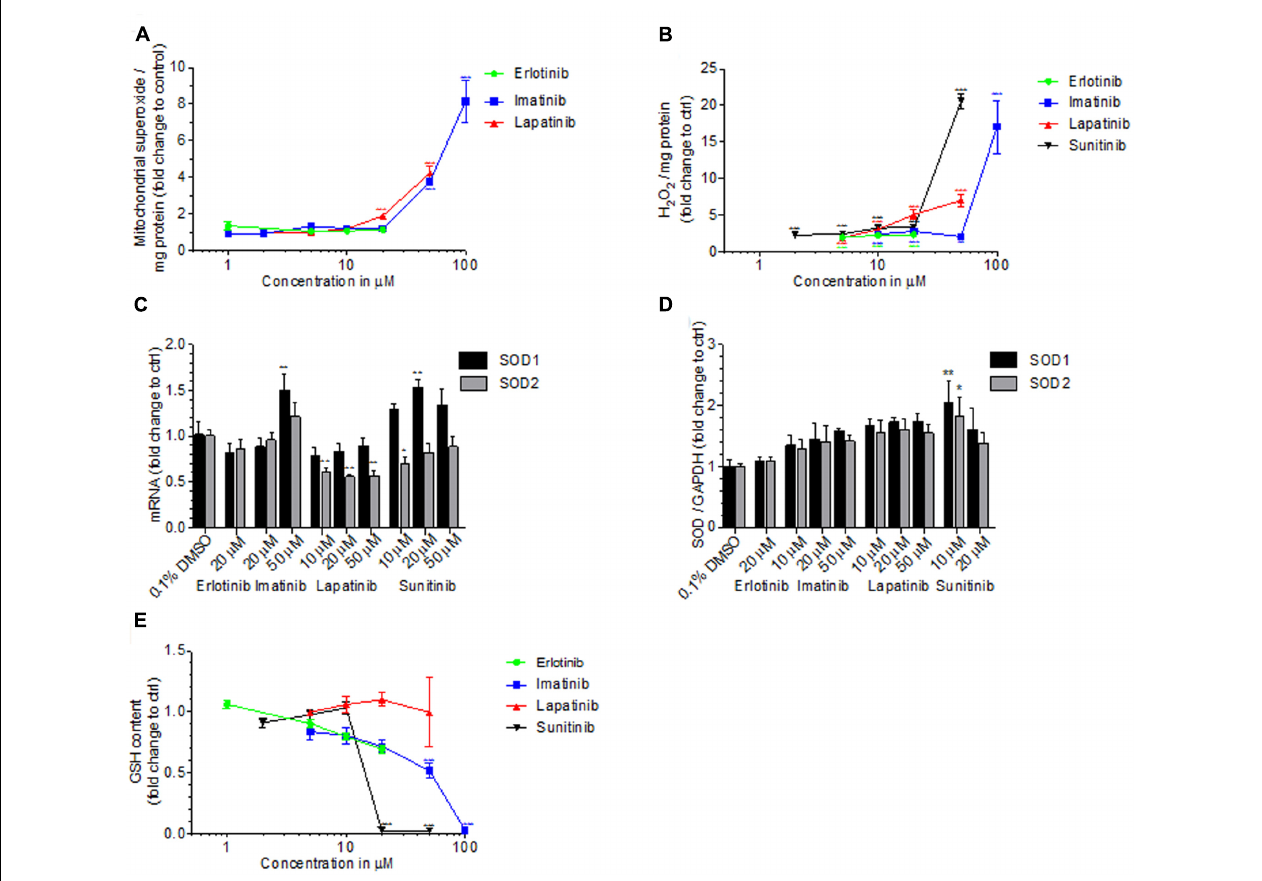
FIGURE 6 | Cellular and mitochondrial ROS production, cellular GSH content and SOD expression. (A) Mitochondrial ROS production by HepG2 cells after drug exposure for 48 h. (B) Production of H 2 O 2 by HepG2 cells after drug exposure for 48 h. (C) mRNA expression of SOD1 and SOD2 in HepG2 cells after drug exposure for 48 h. (D) Protein expression of SOD1 and SOD2 in HepG2 cells after drug exposure for 48 h. (E) GSH content in HepG2 cells after drug exposure for 48 h. Basel GSH concentration of control incubations (0.1% DMSO) was 24.4 ± 6.0 µ M. All data are expressed as fold change to control incubations containing 0.1% DMSO. Data represent the mean ± SEM of at least three independent experiments. ∗ p < 0.05, ∗∗ p < 0.01 or ∗∗∗ p < 0.001 versus DMSO